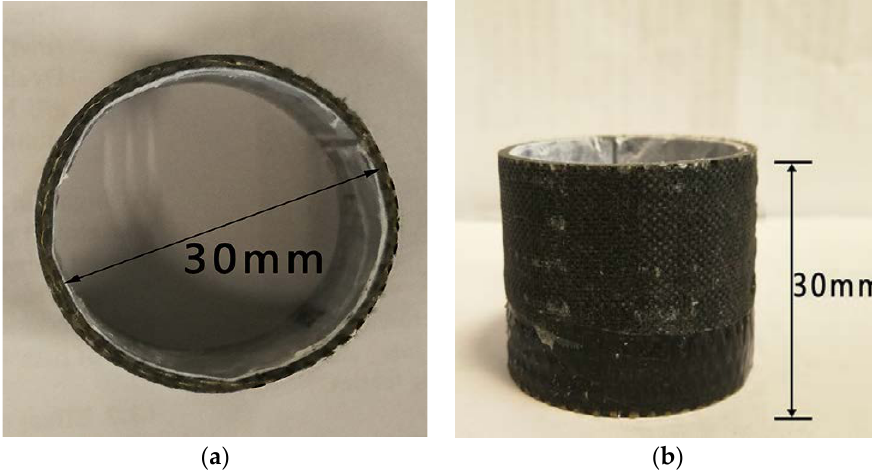
Figure 5. Photograph of the 3D tubular woven composites: (a) Diameter image; (b) Height image.